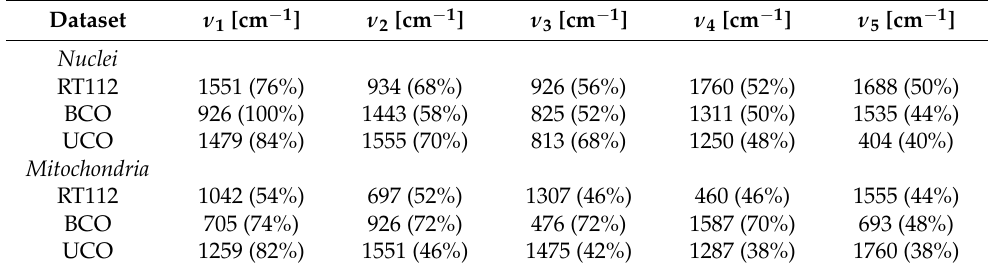
Table 2. Most frequently occurring wavenumbers upon treatment